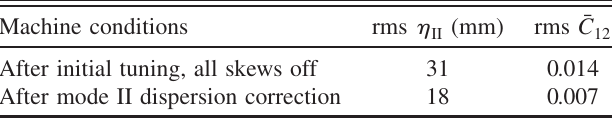
TABLE II. Results of an initial test of mode II dispersion correction in CesrTA. The rms values are the root mean squares of the measurements at all